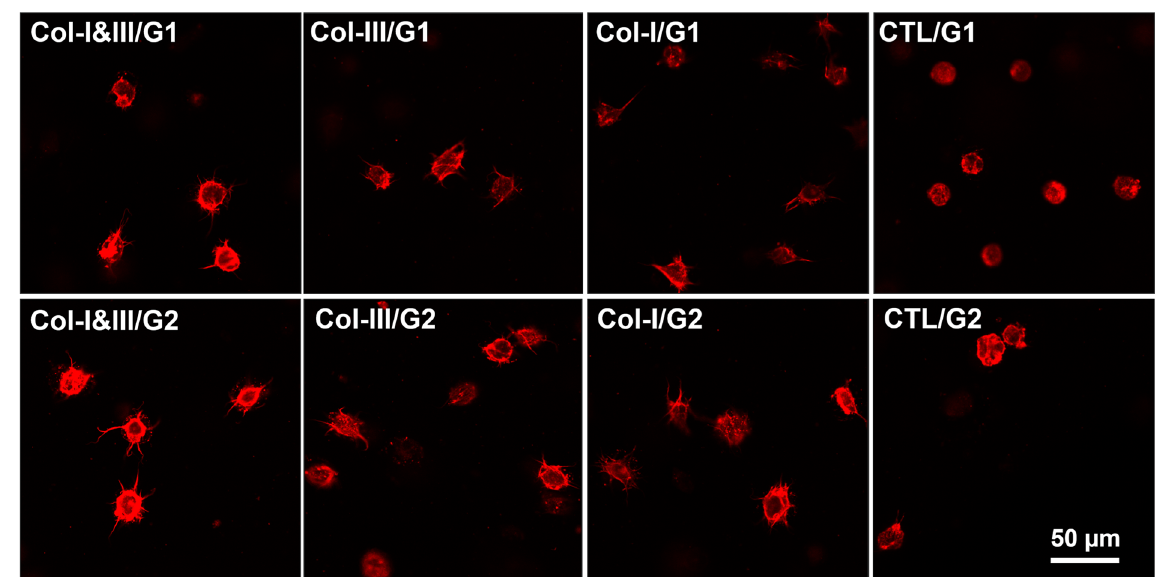
Figure 6. Representative fluorescent images of encapsulated cells in the collagen (Col)/glycol-chitosan (GCS) hydrogels and negative controls after 7 days in culture. The cells had a rounded shape at the initial time (not shown here). Growing actin stress fibers were found for cells cultured in the Col/GCS hydrogels, unlike those in the negative controls with a completely rounded shape. Larger actin fibers were found for the cells encapsulated in the hybrid hydrogels for 7 days compared with those cultured for only 2 days (Refer to Supplementary Fig. A.1). It was inferred that the cells adhered to the Col/GCS